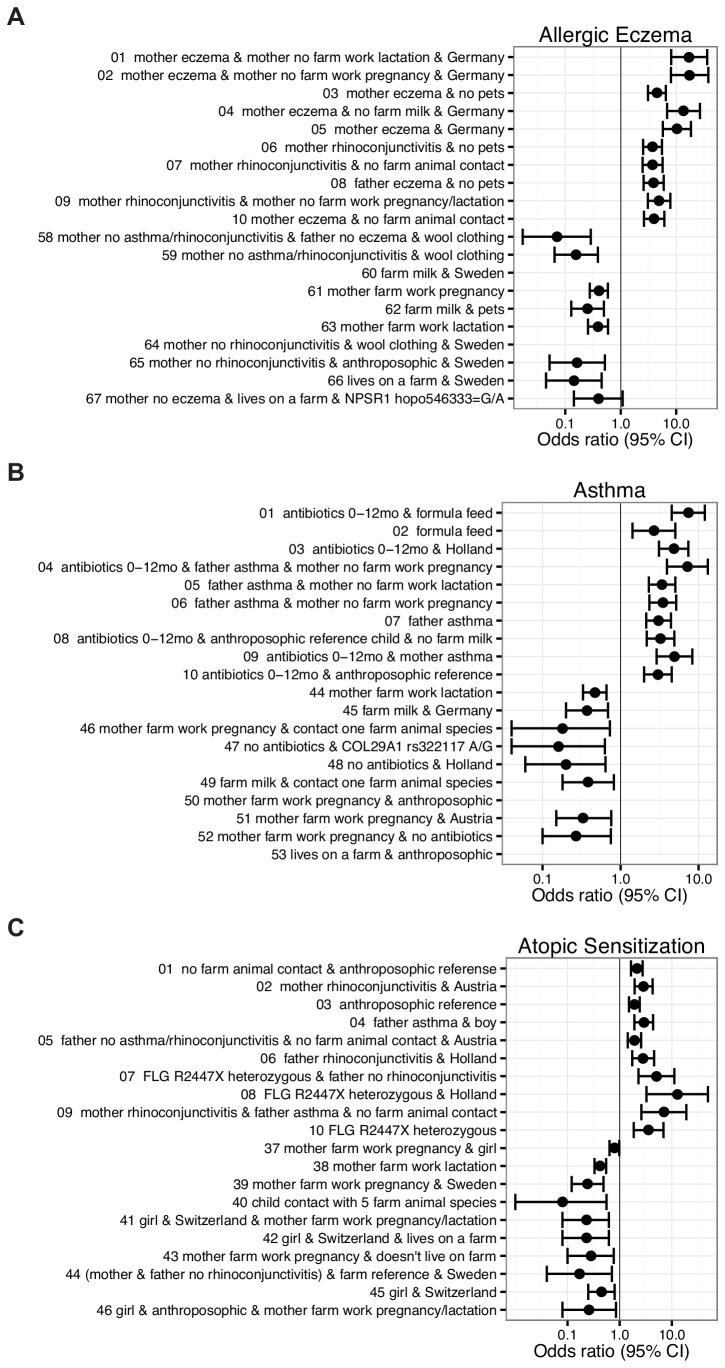
Combinations of genetic variants and/or environmental factors in relation to allergy and asthma in PARSIFAL.Odds ratios are shown for the top-hits rules identified for (A) allergic eczema; affected1-10 and unaffected58-67 (B) asthma; affected1-10 and unaffected44-53 and (C) atopic sensitization; affected1-10 and unaffected37-46. The odds ratios were calculated for children that fulfill all conditions in the rule using all other children as reference.